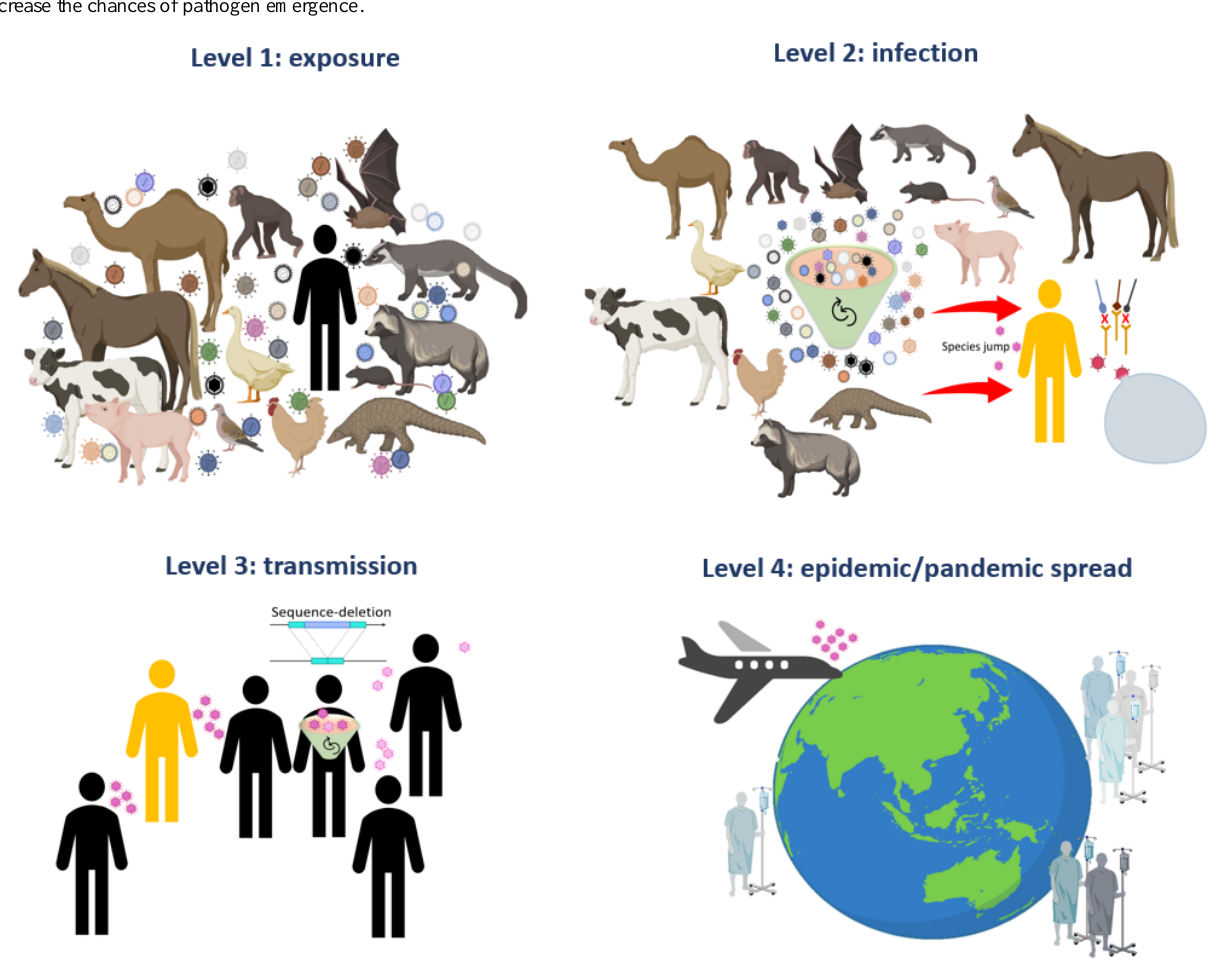
Figure 1. The four-level model of pathogen emergence. Bushmeat production, poultry and livestock industries, and live-animal markets warrant frequent close animal-human and animal-animal contact and increase exposure to pathogens circulating in different species. Frequent exposure (level 1) can turn into a productive infection (level 2), given the necessary viral adaptation has taken place to make humans susceptible. By passaging through humans, the new virus may undergo further adaptation. Pandemic emergence necessitates an efficient human-to-human transmission for sustained propagation. Fast human movement across the globe amplifies the chain of transmission. Efforts should be directed at preventing level 1 (exposure) to significantly decrease the chances of pathogen